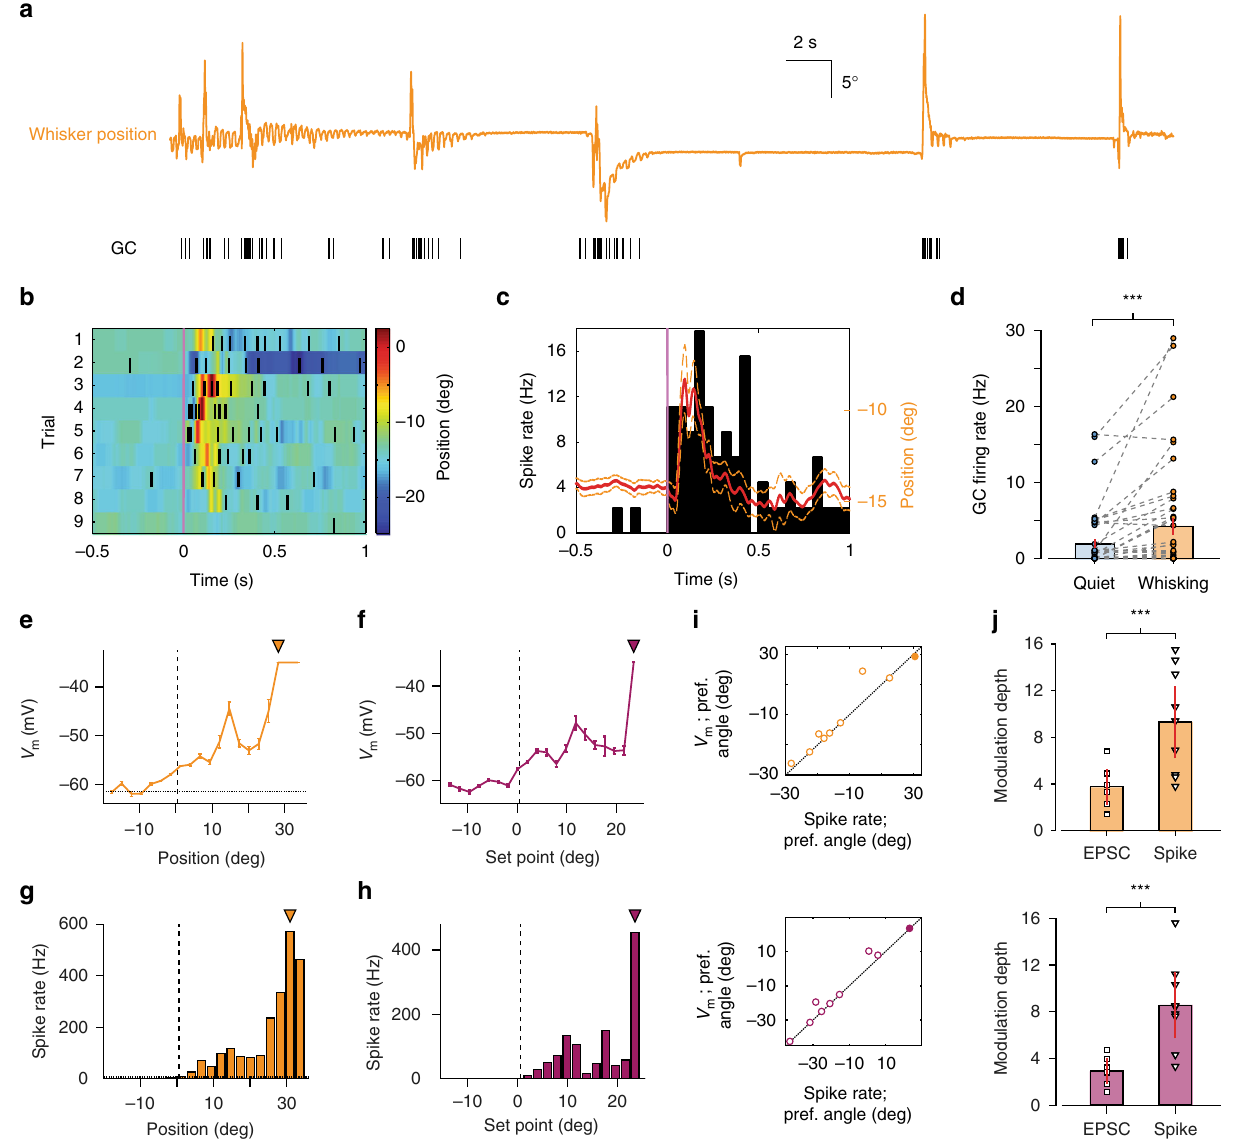
Fig. 4 Kinematic tuning of granule cell output. a Whisker position ( orange ; upward de fl ection indicating protraction) and corresponding GC spike train. b Colour-coded whisker movement from nine consecutive epochs (trials) and corresponding spike raster from single GC. c Mean whisker position ( red line ; orange : S.E.M.) and peri-event time histogram ( PETH ) of GC spiking for all trials. Firing rates were computed from PETH with 50 ms bin size. d GC fi ring rate changes between quiet and whisking epochs from WC and CA recordings (*** P < 0.001, Wilcoxon signed-rank test, n = 32 WC and n = 13 CA). e , f Average V m with respect to whisker position e and set point f for a single GC. Filled triangles : preferred angles. Dashed horizontal line in e indicates average quiescent V m . Vertical line indicates whisker resting position. g , h Histogram of spike rate with respect to whisker position g and set point h for the same GC. The overall pro fi le of angular tuning is similar to V m , but sharper. Filled triangles : preferred angles. Dashed horizontal line in g indicates resting fi ring rate. Vertical line indicates whisker resting position. i Correspondence between preferred angle for V m and spike rate for all GCs ( n = 9). Filled circle : GC shown in e – h . j . Modulation depth of EPSC rate (i.e. synaptic input) and GC spike rate (i.e., output) with respect to whisker position ( top ) and set point ( bottom ). Modulation depth was signi fi cantly higher for output (*** P < 0.001, Mann – Whitney U -test; n = 6 input and n = 9 output for position; n = 7 input and n = 9 output for set